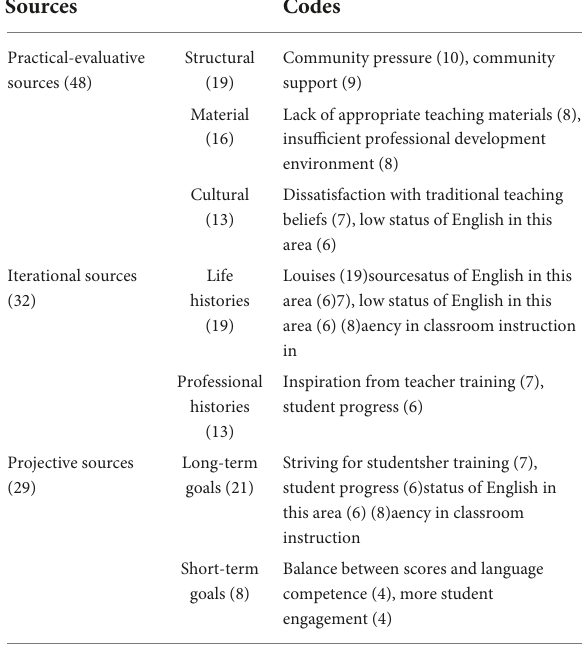
TABLE 2 Overall coding results on the sources of